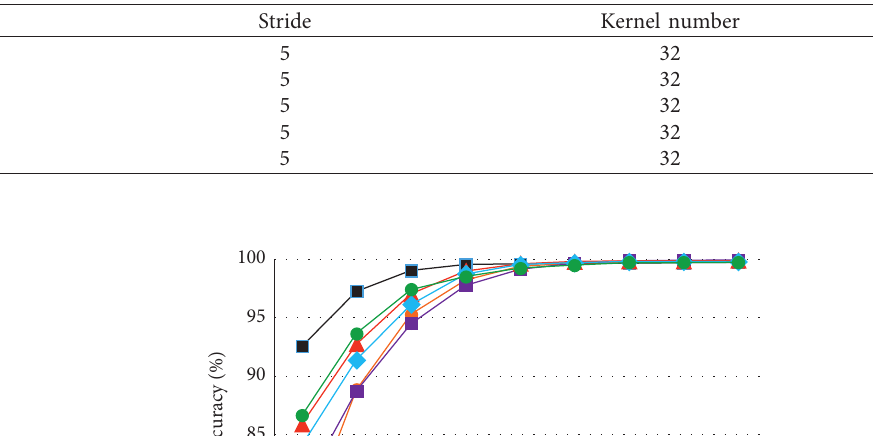
Table 1: Parameters of the single-scale convolutional structure.